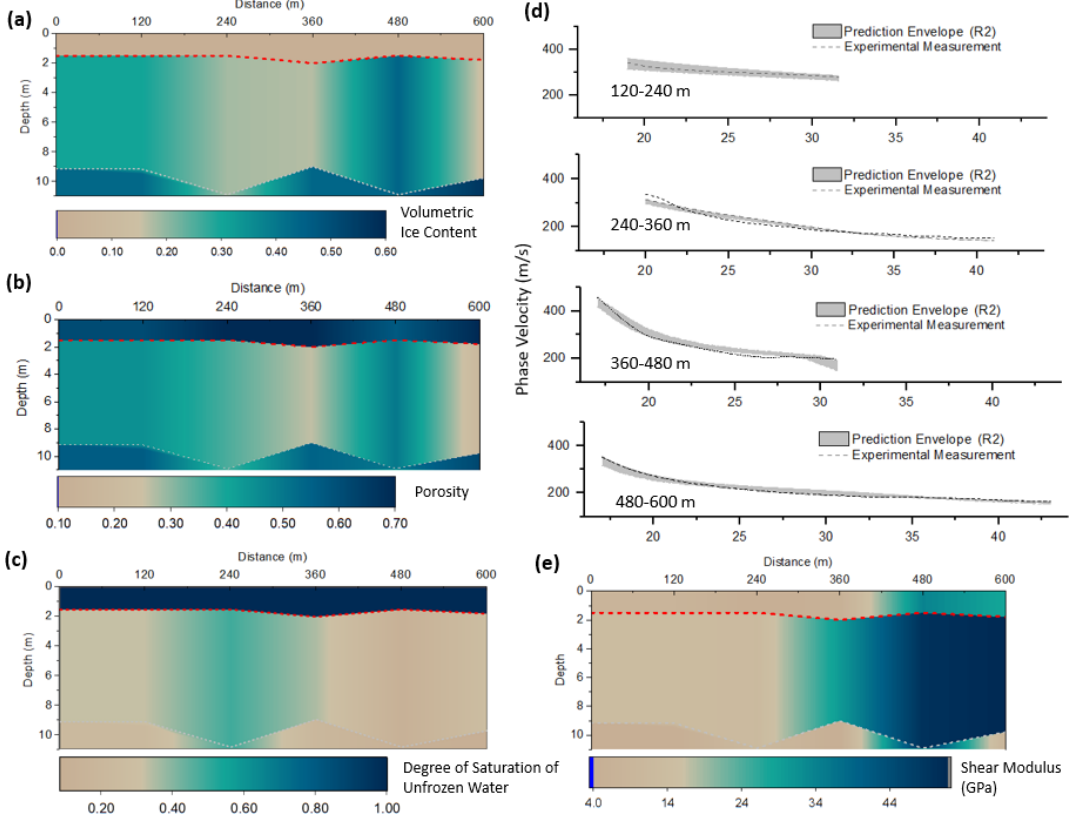
Figure 6. Summary of the inversion results at the offset distance from 0m to 600m. (a) Volumetric ice content distribution. (b) Soil porosity distribution. (c) Degree of saturation of unfrozen water distribution. (d) Comparison between the numerical and experimental dispersion curves for the R2 wave. (e) Distribution of the shear modulus of the solid